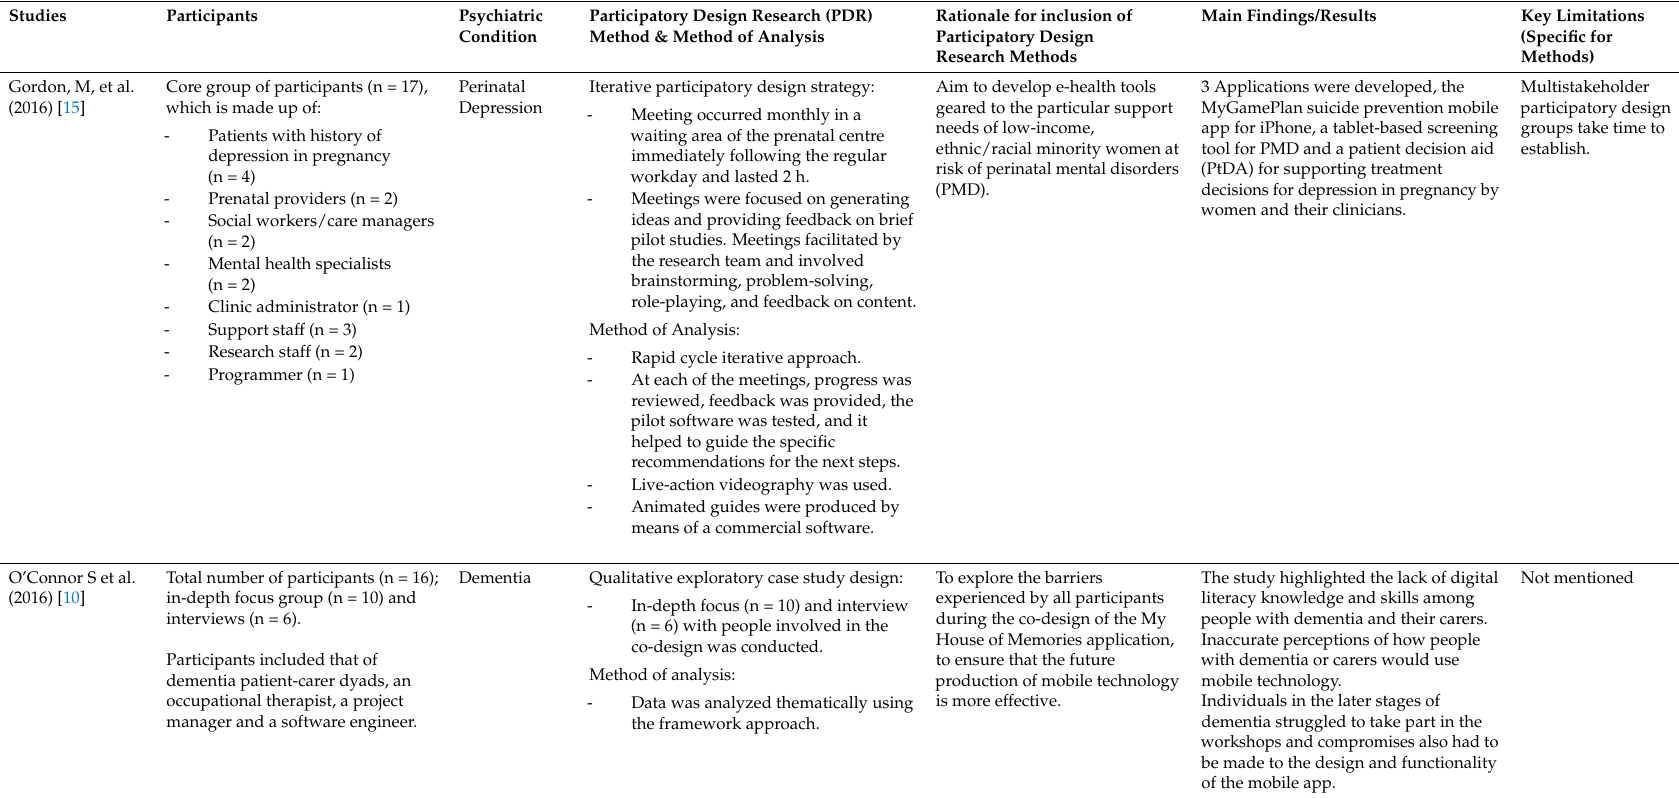
Table 1. Characteristics of the Included